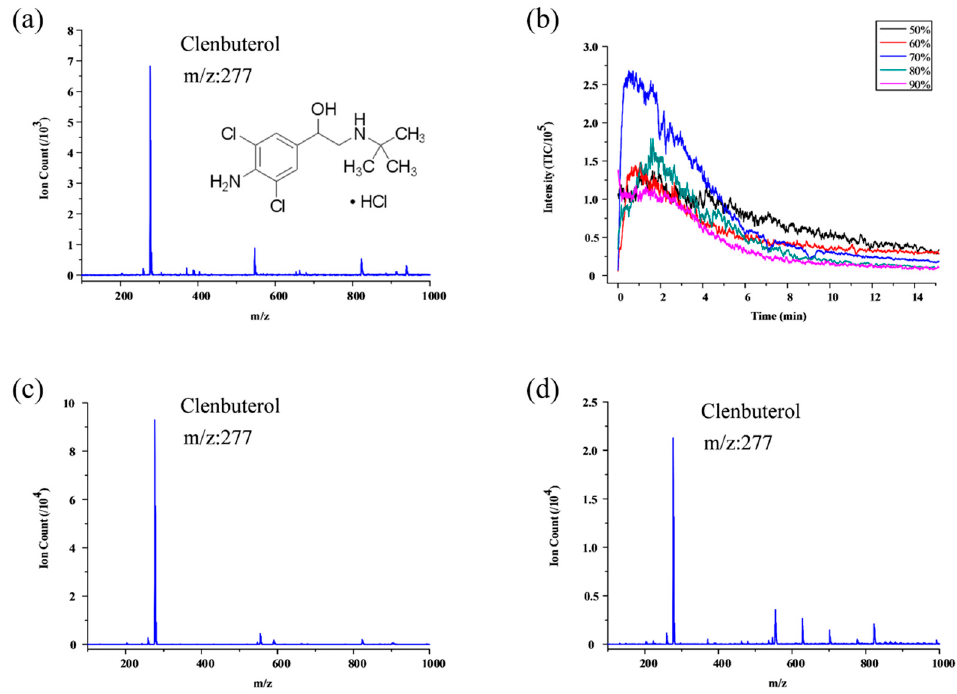
Figure 5. Results of SPME using standard sample: ( a ) 15.9 µM clenbuterol hydrochloride ion counts of the 15 min mean signal by commercial capillary; TIC mass range from 100 to 1000; ( b ) Different acetonitrile and water ratio with 5% ammonium hydroxide used as eluent and clenbuterol hydrochloride change within 15 min on elution; TIC mass range from 276 to 277; ( c ) clenbuterol hydrochloride ion counts by optimal chip configuration; ( d ) Clenbuterol hydrochloride ion counts by optimal chip configuration; the concentration is 3.2 µM.